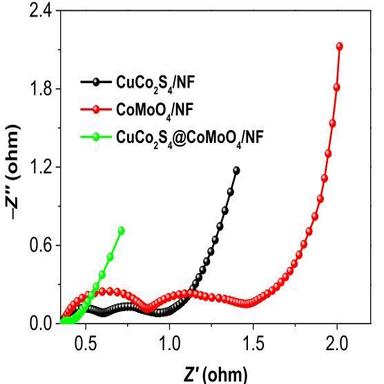
Nyquist plots obtained for the CuCo2S4/NF, CoMoO4/NF, and CuCo2S4@CoMoO4/ NF electrodes.